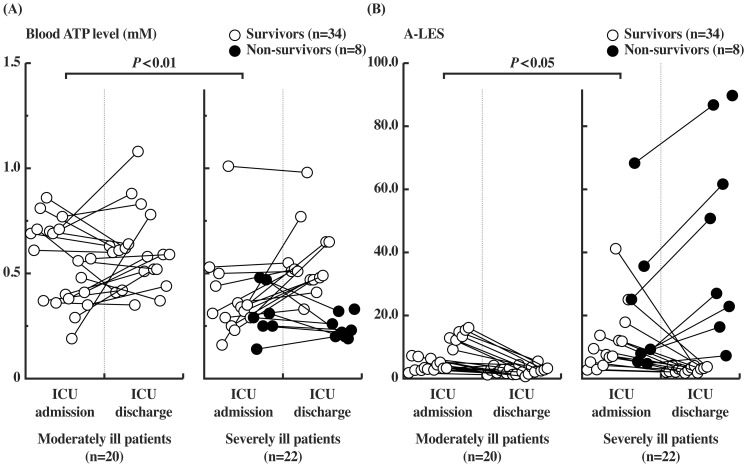
Changes in blood ATP and A-LES levels in moderately and severely ill patients.(A) Blood ATP levels and (B) A-LES values at ICU admission and ICU discharge. Symbols are paired data of individual patients. (○): survivors, (•) non-survivors. Levels of ATP and A-LES at ICU admission in severely ill patients were significantly lower than those in moderately ill patients (P<0.01 for ATP and P<0.05 for A-LES).